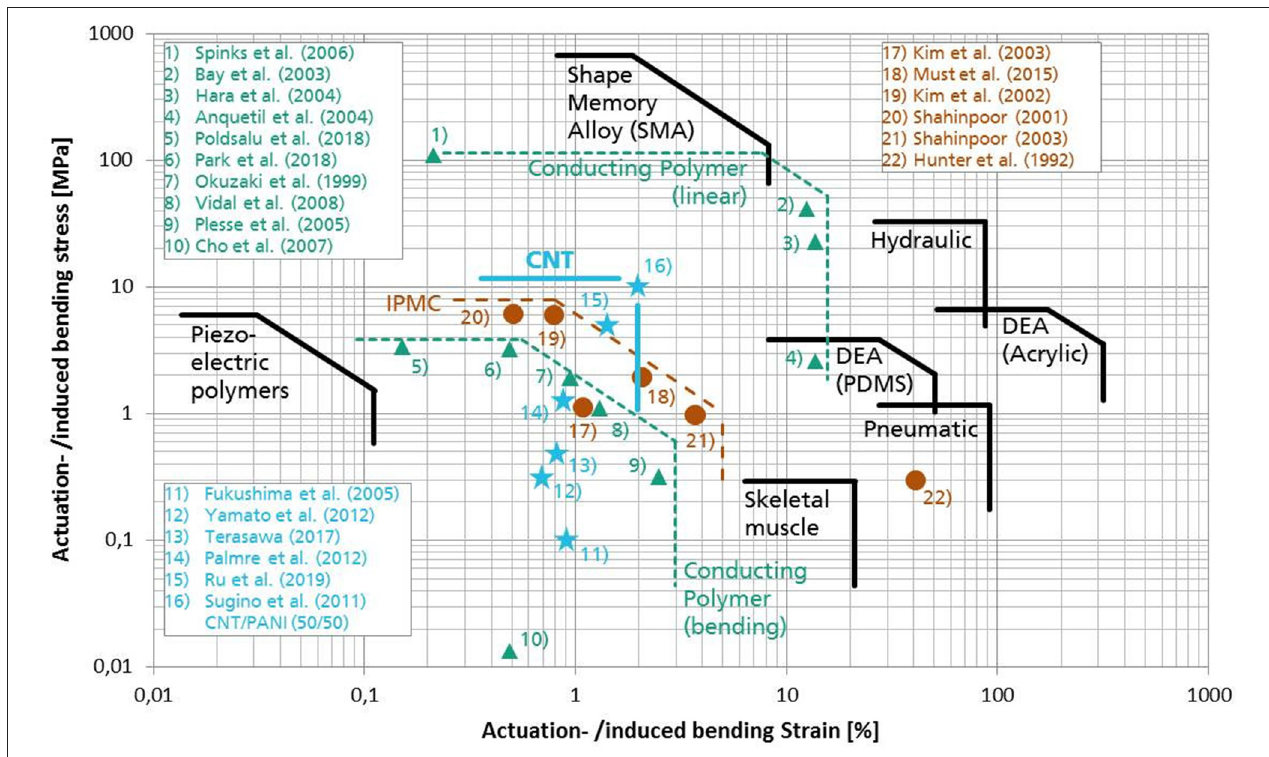
FIGURE 1 | Stress vs. strain of typical actuator technologies (solid black lines) and some state-of-the-art ionic EAP actuators operable in air – inspired by Simaite (2015) and based on sources referenced in the